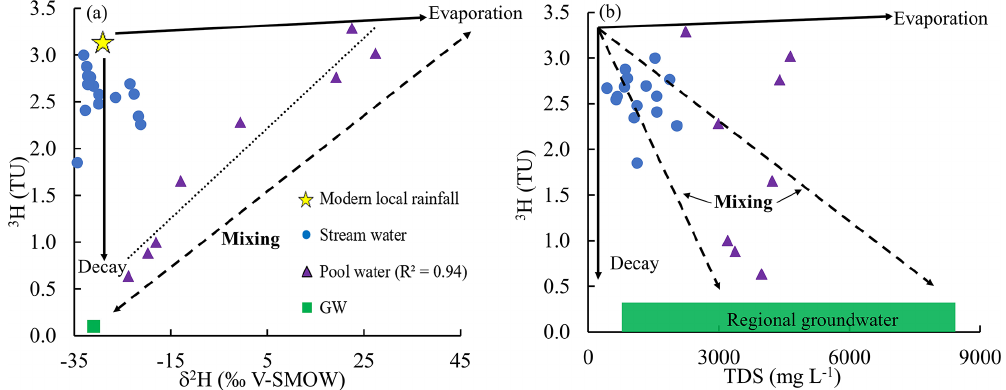
Figure 6. (a) Variation of 3 H activities and δ 2 H values, and (b) 3 H activities and TDS of stream water, pool water, and groundwater (GW) in the upper Wimmera Catchment. Arrows show trends expected from evaporation and mixing. Data from Tables S1 and S2.